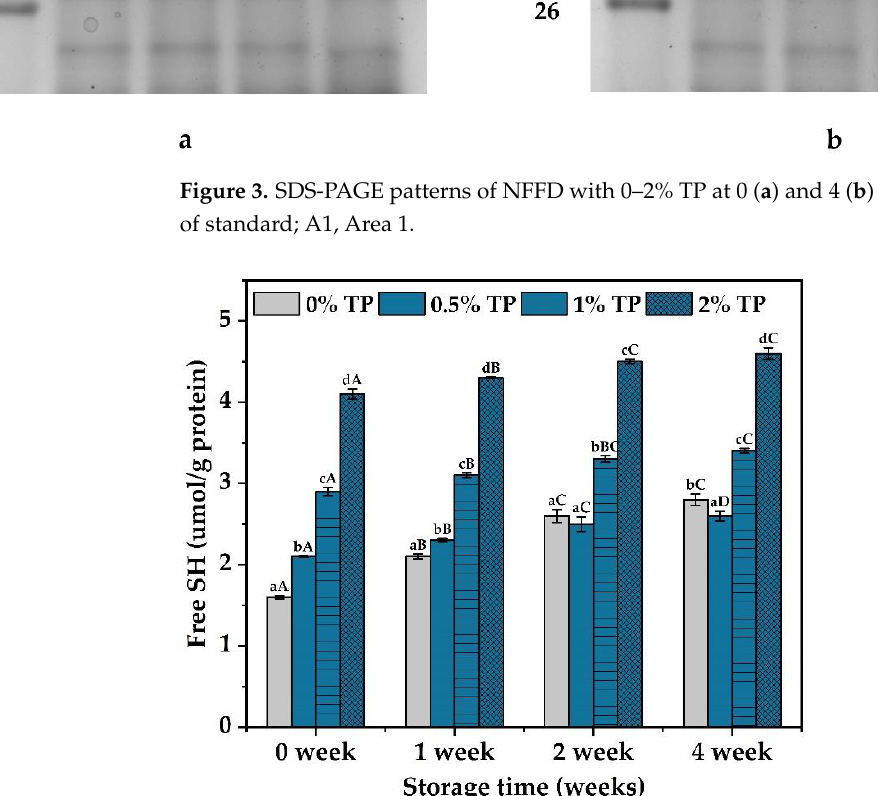
Figure 5. Infrared spectra of NFFD at both 0 and 4 weeks, stored at − 20 °C with various TP additions. Amide I band (1600 – 1700 cm −1 ) is one of the most important characteristic bands to determine protein secondary structure [29]. The characteristic peaks at 1670 cm −1 and 1633